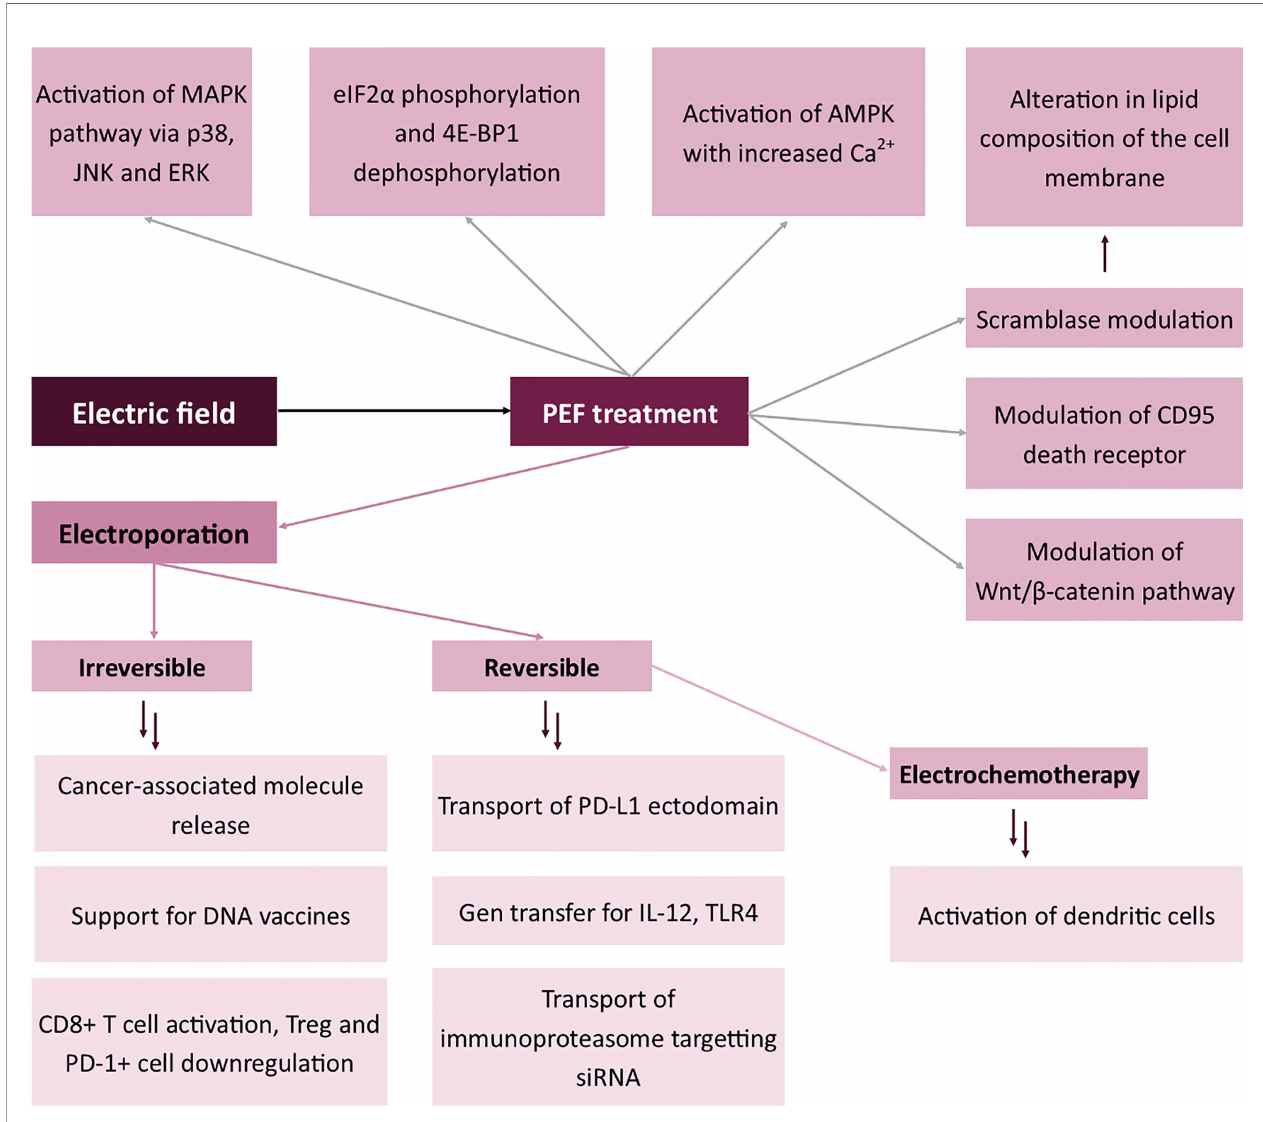
FIGURE 4 | Effects of electric fi eld on the expression of membrane antigens. Mitogen-activated protein kinase (MAPK), c-Jun N-terminal kinase (JNK), Extracellular signal-regulated kinase (ERK), Eukaryotic Translation Initiation Factor 2A (eIF2 a ), Eukaryotic translation initiation factor 4E-binding protein 1 (4E-BP1), 5 ’ AMP- activated protein kinase (AMPK), Programmed death-ligand 1 (PD-L1), Toll-like receptor 4